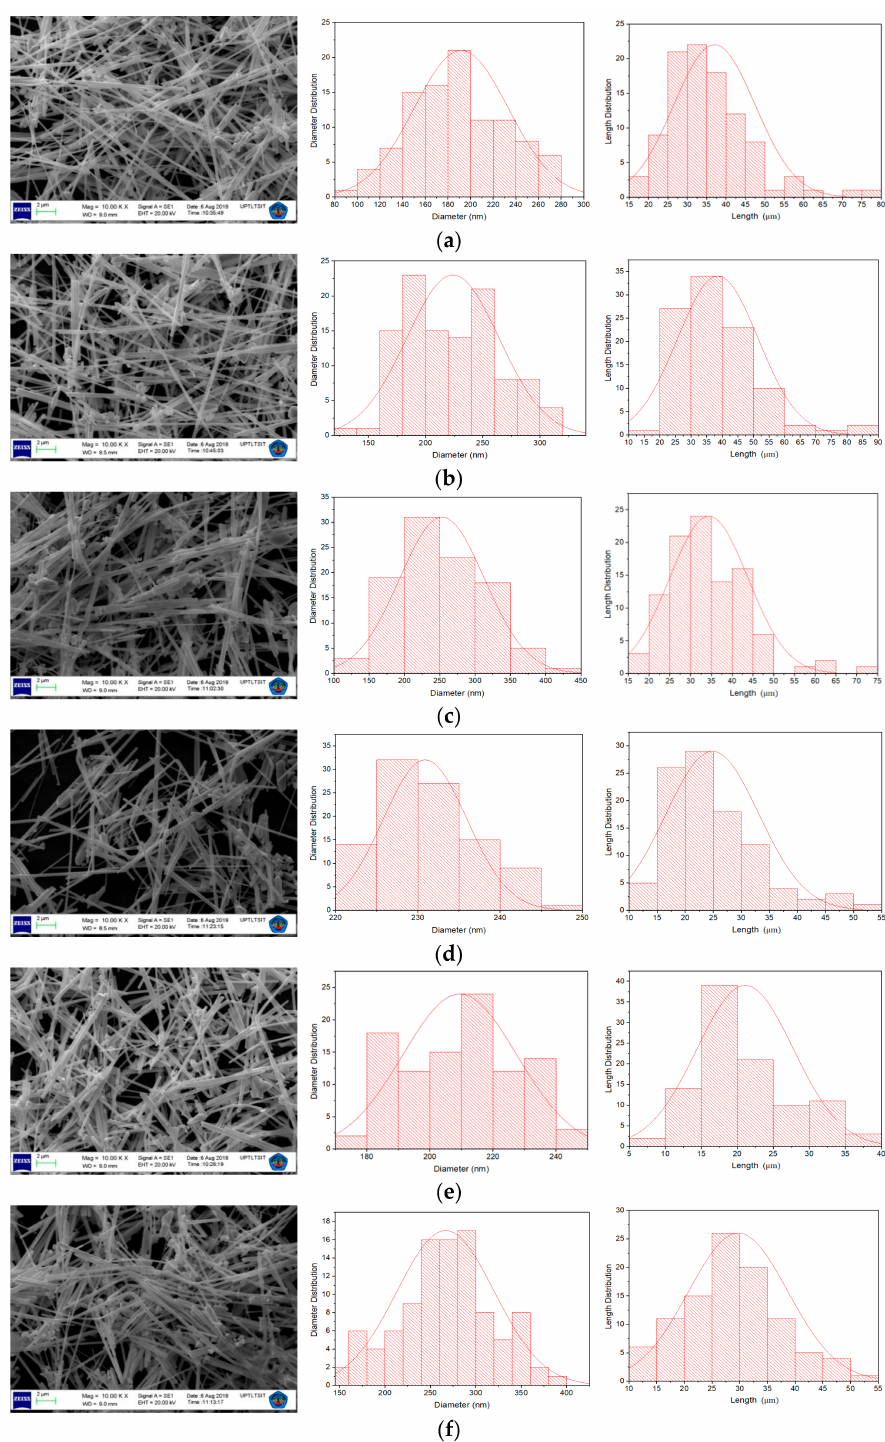
Figure 2. SEM images the morphology of AgNWs at quenching medium temperature ( a ) 27 ◦ C, ( b ) 0 ◦ C, ( c ) − 80 ◦ C, ( d ) 27 ◦ C was vibrated, ( e ) 0 ◦ C was vibrated, and ( f ) − 80 ◦ C was